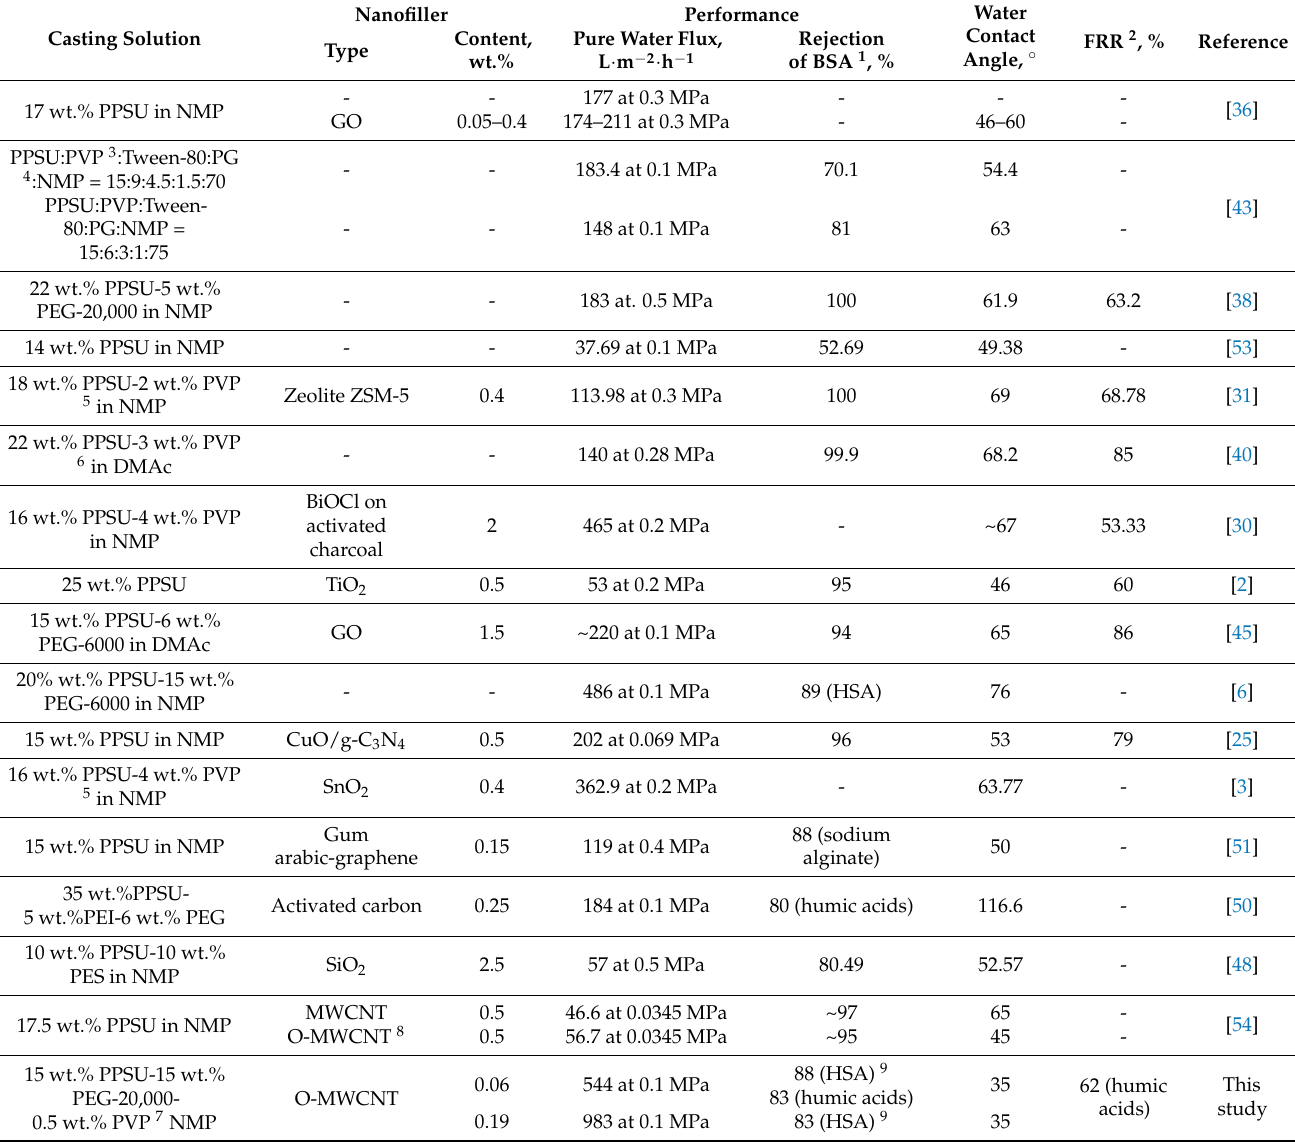
Table 1. Performance of PPSU ultrafiltration membranes reported in the literature to date.